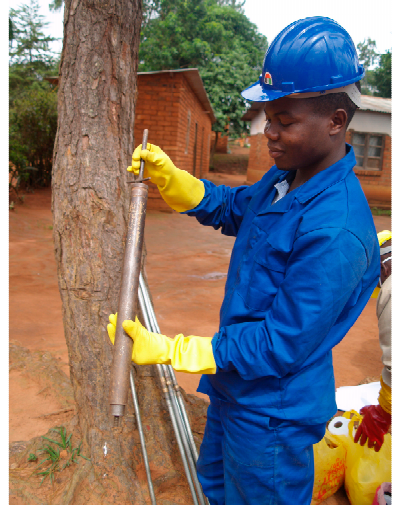
Figure 1. Dynamic cone penetrometer.